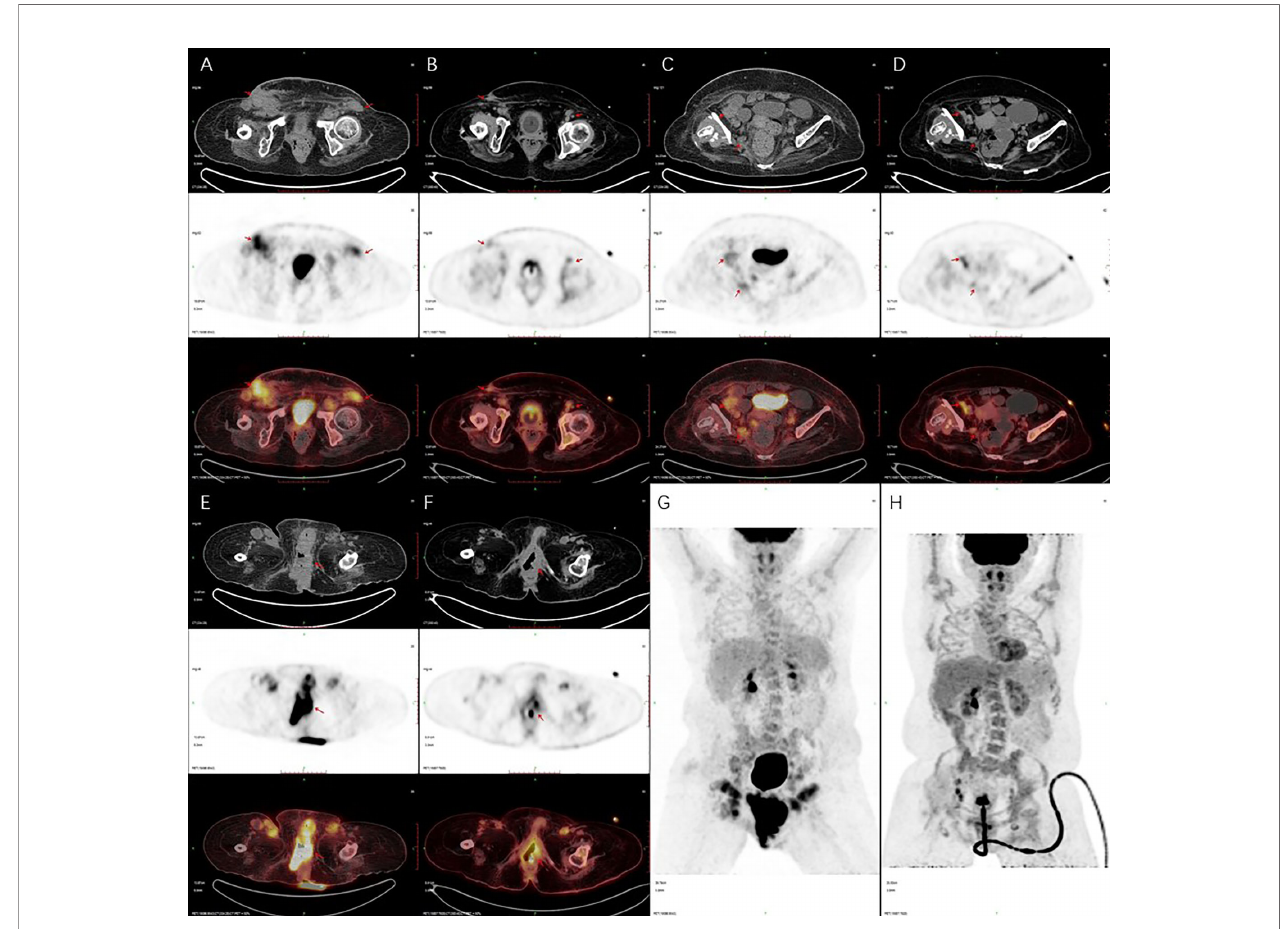
FIGURE 3 | Positron emission tomography/computed tomography (PET/CT) imaging. PET/CT scan showed that metastatic lymph nodes were smaller and less than before (A – D) , and the vulva lesions were smaller than before (E – H) . (A, C, E, G) are PET/CT imaging taken in January 2019. (B, D, F, H) are PET/CT imaging taken in October 2019.